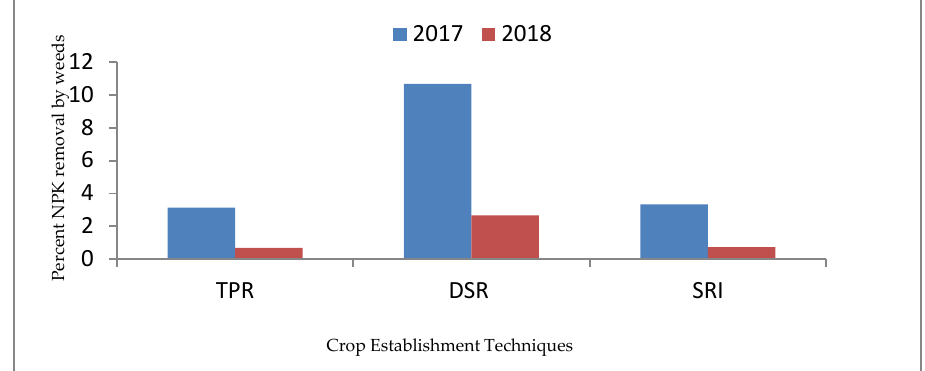
Figure 3. Proportion of nutrient uptake by weeds from total uptake (plants + weeds NPK uptake) under crop establishment techniques.